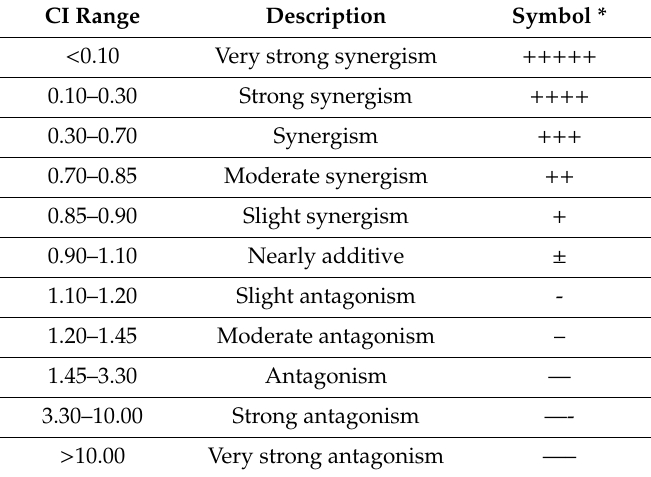
Table 6. The classification of the combination index (CI), their indication, and symbols in drug combination studies analyzed with the CI method which is based on those described by Chou and Talalay and the CompuSyn software of Chou and